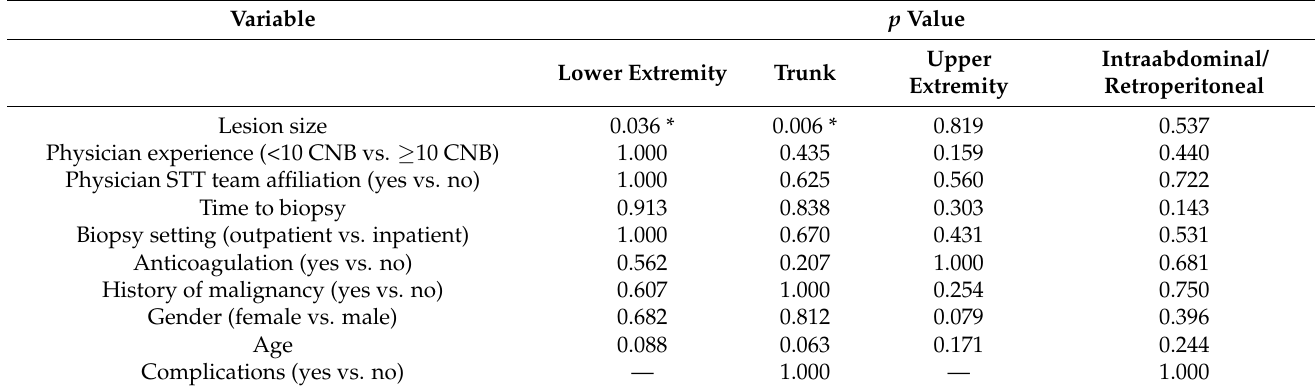
Table 2. Factors associated with inconclusive CNB.